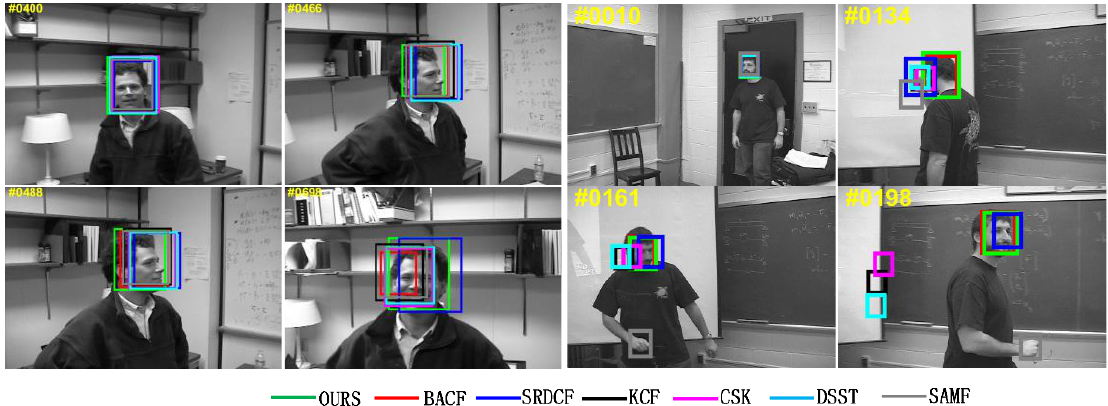
Figure 10. Tracking results of seven trackers on FleetFace ( left ) and Freeman1 ( right